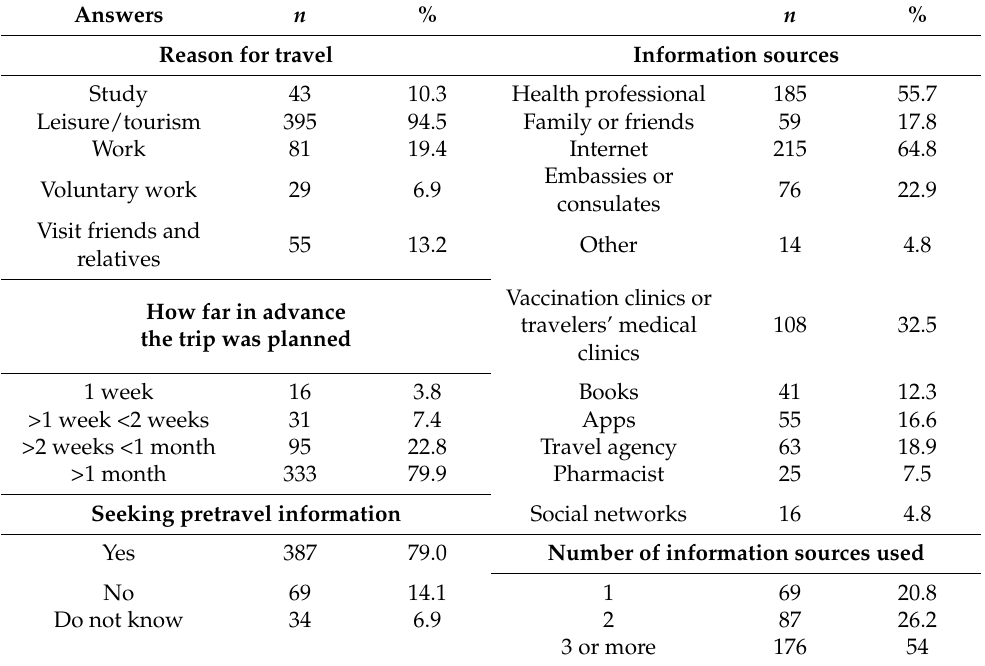
Table 2. Travelers’ attitudes and behaviors.